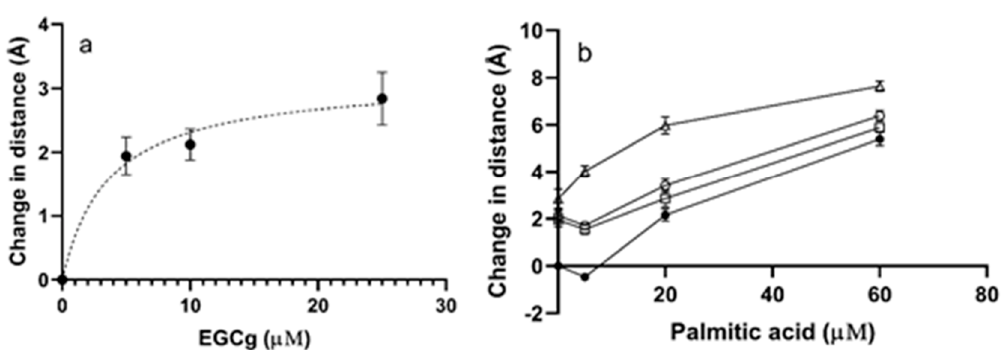
Figure 4. FRET distance between Trp-214 and CPM for HSA (1 μ M with 0–25 μ M of EGCg and/or 0–60 μ M PA. The data points are means calculated from three replicates and the error bars indicate SEM. ( a ) FRET distance between Trp-214 and CPM with different concentrations of EGCg (0–25 μ M). Bmax was 3.2 Å and apparent EC 50 was 3.7 μ M based on a saturation binding model for one ligand. ( b ) FRET distance between Trp-214 and CPM in the presence of PA (5, 20, 60 μ M) and EGCg (0, 5, 10, 25 μ M). ● , 0 μ M EGCg; □ , 5 μ M EGCg; о , 10 μ M EGCg; ∆ , 25 μ M EGCg. The saturation binding model